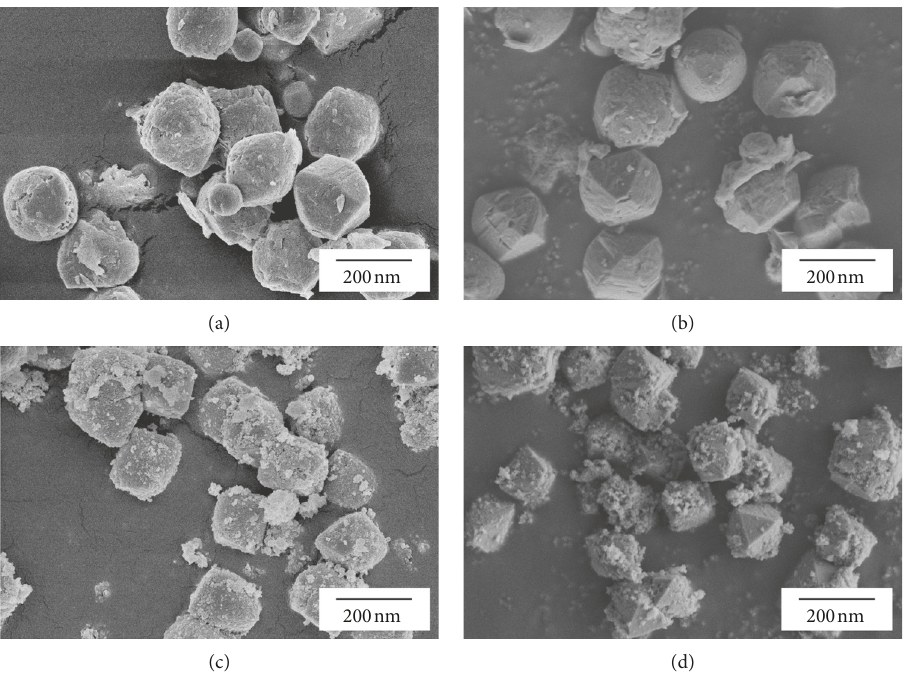
Figure 3: Field-emission scanning electron microscopic images of the synthetic natroalunite and the synthetic arsenic-incorporated natroalunite before and after dissolution at 25 ° C for